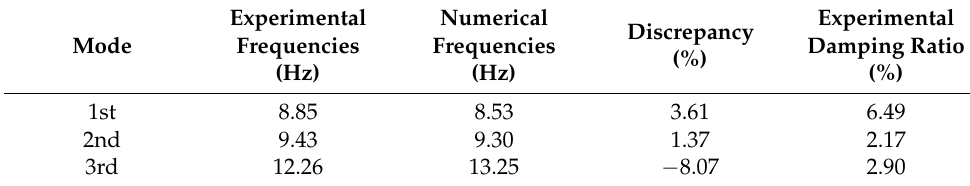
Table 4. Ranges of values considered for the sensitivity analysis.